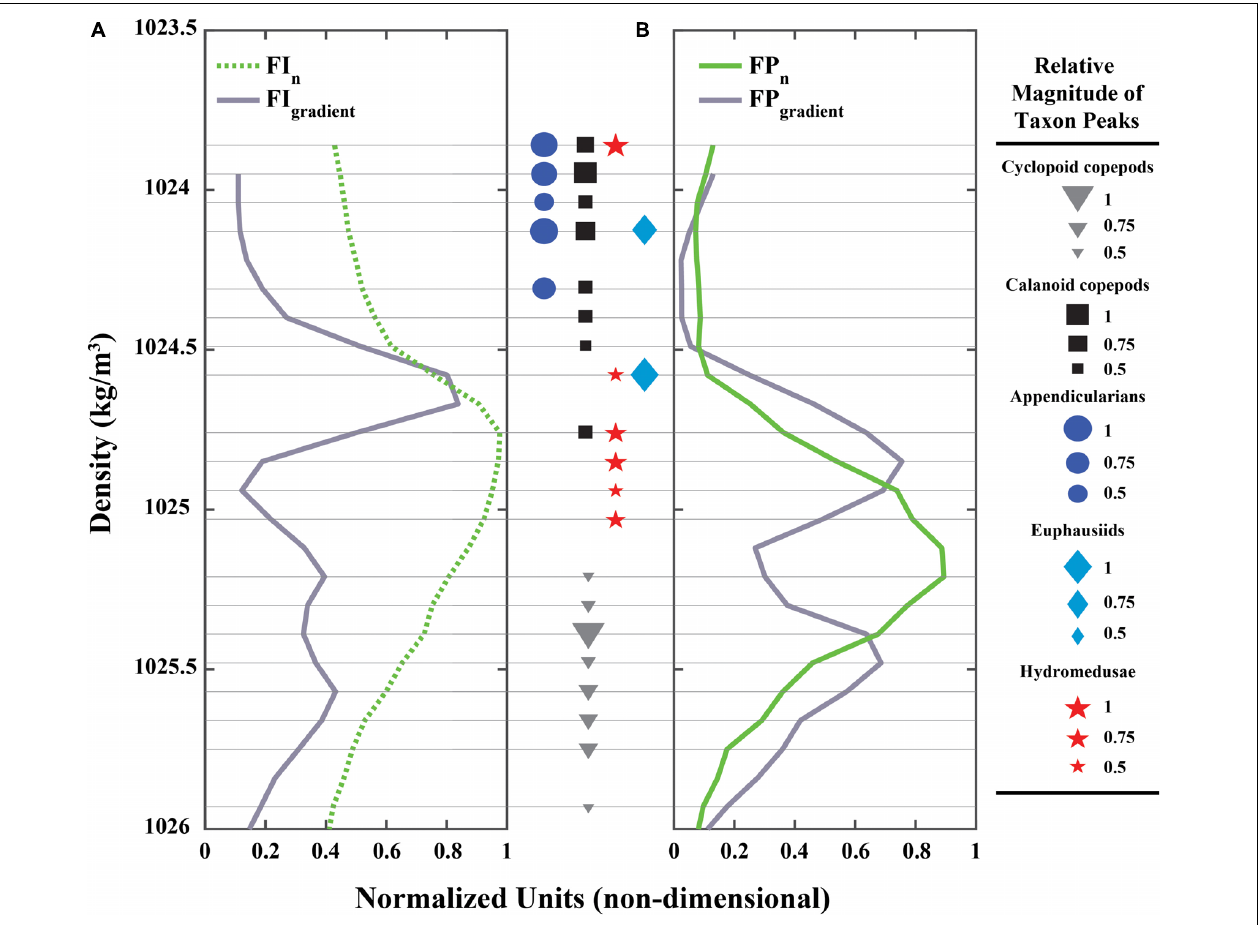
FIGURE 8 | (A) Normalized, time-averaged Fluorescence Intensity (FI n ) profile (green dotted line) and its vertical gradient (FI gradient ; gray solid line). (B) Normalized, time-averaged PLIF Fluoresence Particles (FP n ) profile (green solid line) and its vertical gradient (FP gradient ; gray solid line) in water density space. Markers (sizes are relative magnitude of raw counts of the peak) between (A,B) represent zooplankton peaks (95% probability of being higher than background values; see Supplementary Figure 2 ) and are the thin gray horizontal lines show their vertical position in relation to (A,B) . Colors are the same as in Figure 7B for each zooplankton group: calanoid copepods (black squares), cyclopoid copepods (gray triangles), appendicularians (dark blue circles), euphausiids (light blue diamonds), and hydromedusae (red